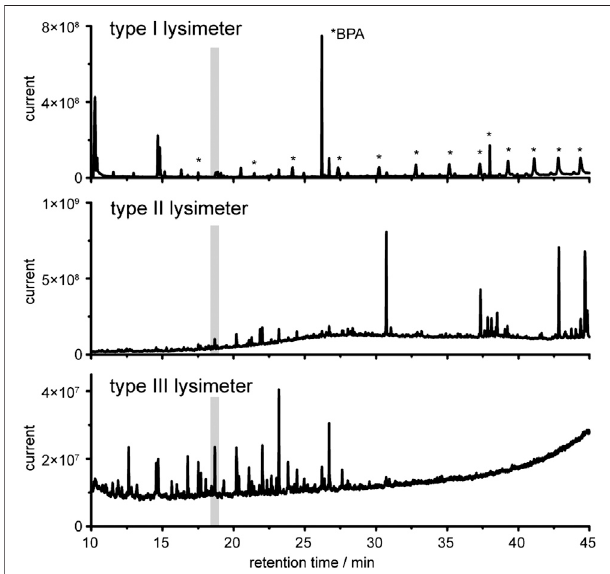
FIGURE 4 | Gas chromatography coupled to mass spectrometry (GC- MS) analysis of derivatized water extracts collected by the lysimeters. Gray marked is the internal standard ribitol as penta-TMS derivative. Note, the relative intensities differ in each plot.